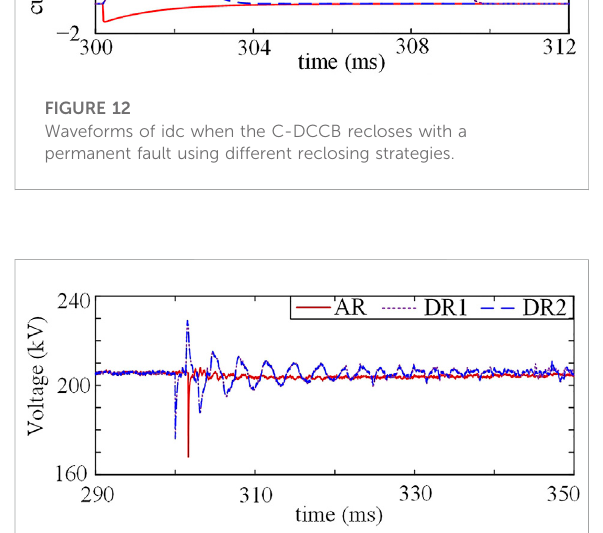
FIGURE 13 Waveforms of ubus1 when the C-DCCB recloses with a transient fault using different reclosing